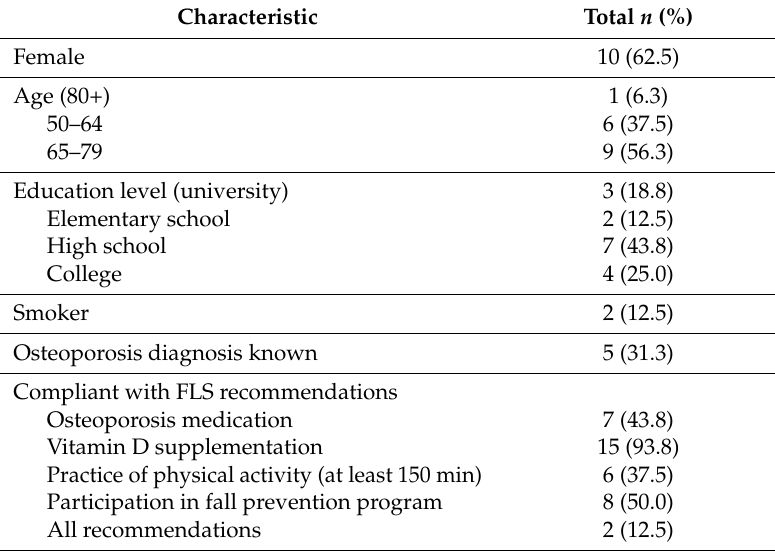
Table 3. Profile of the participants interviewed ( n =